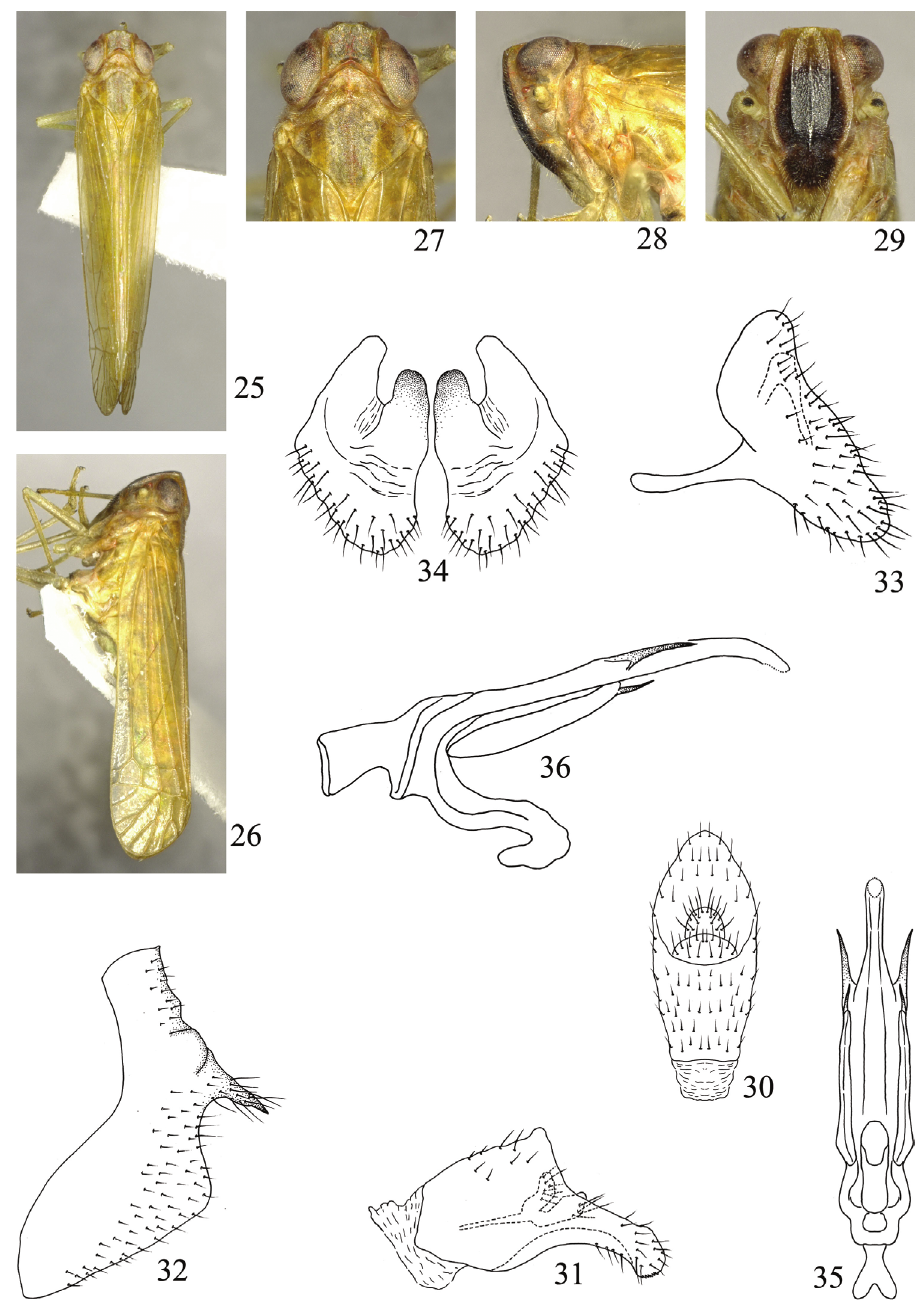
Figures 25–36. Symplanella zhongtua sp. n. 25 Male habitus, dorsal view 26 Male habitus, lateral view 27 Head and thorax, dorsal view 28 Head and thorax, lateral view 29 Face 30 Male anal segment, dorsal view 31 Male anal segment, lateral view 32 Male pygofer, lateral view 33 Style, lateral view 34 Styles, posterior view 35 Aedeagus, ventral view 36 Aedeagus, lateral